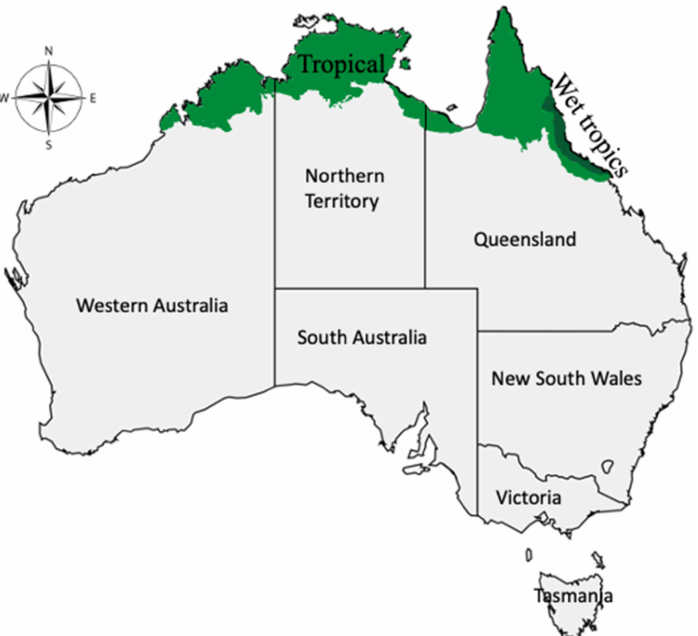
Figure 1. Map of Australia showing the tropical and wet tropics region. (Location labels and compass added; shaded ecoregions were hand-drawn using the information from an online climate map